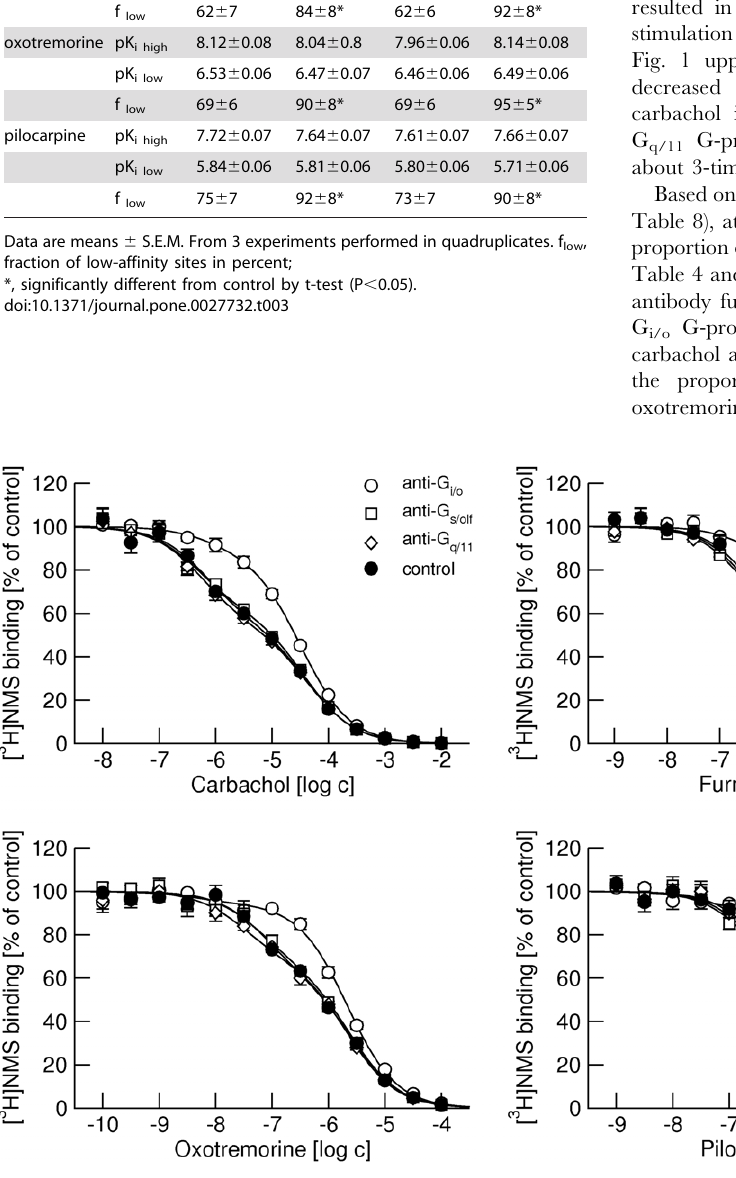
Figure 4. Effects of anti-G-protein antibodies on competition between different agonists and [ 3 H]NMS binding at M 2 receptors. Binding of 1 nM [ 3 H]NMS to membranes from CHO cells expressing M 2 receptors in the presence of increasing concentrations (abscissa, log M) of the agonists carbachol (upper left), furmethide (upper right), oxotremorine (lower left) and pilocarpine (lower right) is expressed as per cent of control binding in the absence of agonist. Filled circles, control binding in the absence of antibodies. Open symbols, binding in the presence of anti-G i/o (circles), anti-G s/olf (squares) and anti-G q/11 (diamonds) antibodies. Data are means 6 S.E.M of values from 3 experiments performed in quadruplicates. Curves were fitted using equation 3 and results of fits are shown in Table 4. doi:10.1371/journal.pone.0027732.g004 PLoS ONE |